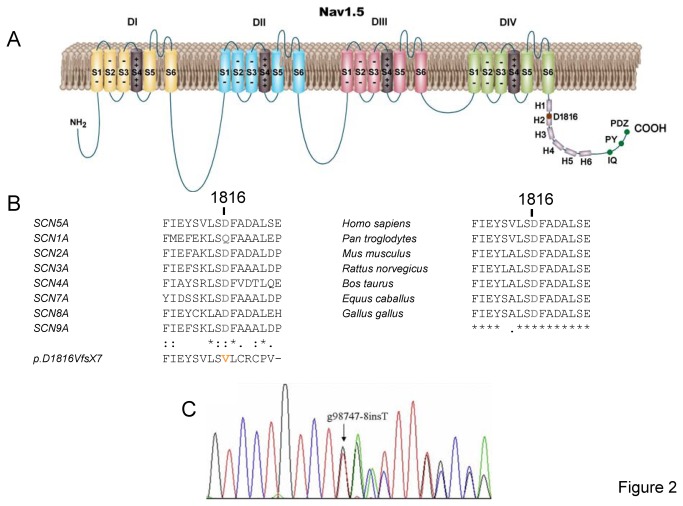
p.D1816VfsX7 mutation characteristics and localization.
A. Topological diagram of Nav1.5 showing the location of D1816 residue. H1 to H6: each of the six α-helices present in the proximal half of the C-terminus. IQ: IQ motif which constitutes a calmodulin binding site. PY: PY motif which constitutes a binding site for E3 ubiquitin-protein ligases. PDZ: PDZ motif which constitutes a binding site for SAP97, PTPH1, and syntrophins. B. Sequence alignments of a segment of the C-terminus of SCN5A homologs in 7 different species and SCNXA family sodium channel expressed in human tissues. The sequence of p.D1816VfsX7 mutation is also shown. The respective accession numbers are NP_001159435.1, NP_001035232.1, NP_001075145.1, NP_000325.4, NP_000326.2, NP_002967.2, NP_001171455.1, and NP_002968.1 for SCN1-5/7-9, and for the different species are: XP_001171891.2 (Pan troglodytes), NP_001240789.1 (Mus musculus), NP_001153634.1 (Rattus norvegicus), NP_776883.1 (Bos taurus), NP_001157367.1 (Equus caballus), and XP_001232818.2 (Gallus gallus). “*” means that the residues in that column are identical in all the sequences in the alignment. “:”indicates conservation between groups of strongly similar properties. “.”indicates conservation between groups of weakly similar properties. C. DNA sequence chromatograms of the proband depicting the heterozigous insertion in exon 28 of SCN5A.